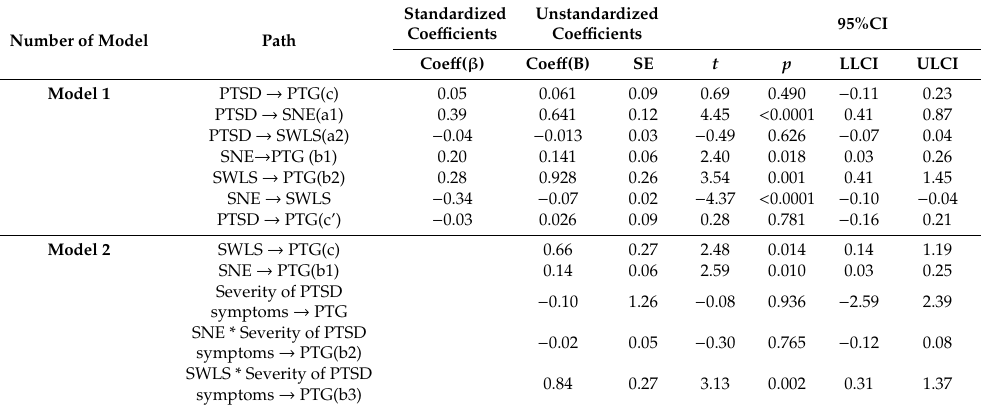
Figure 1. Mediation effect model among symptoms of trauma (PTSD), existential anxiety (SNE), life